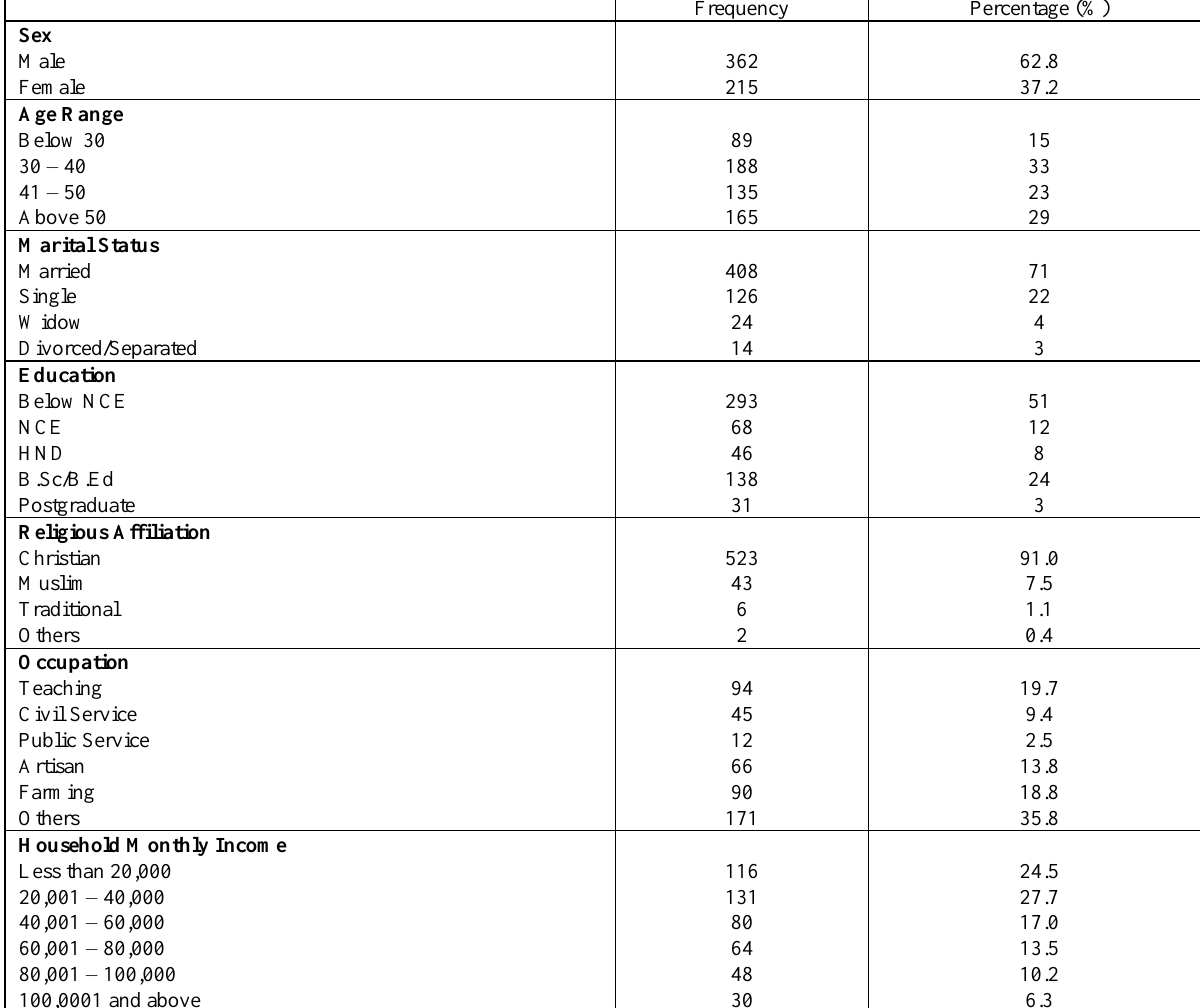
Table 1. Distribution of Respondents by Socio-Economic